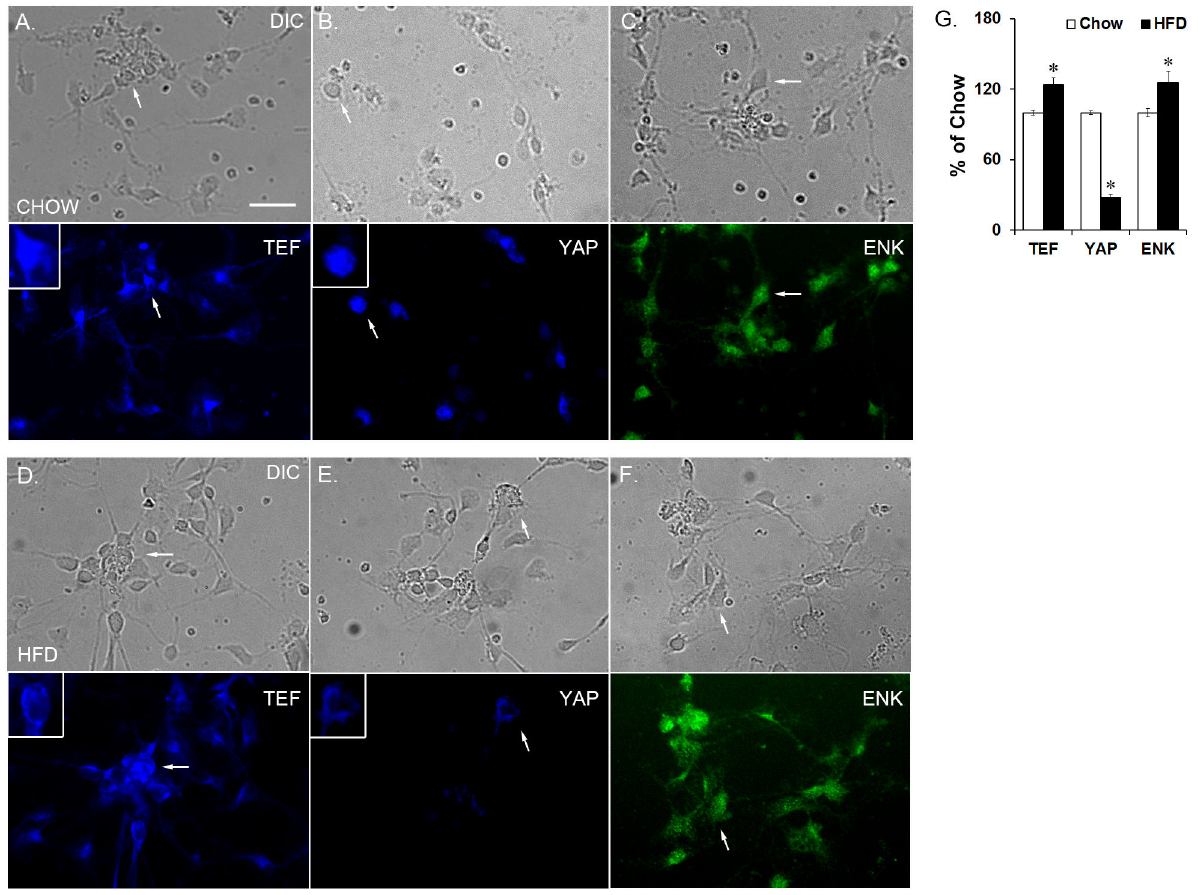
Figure 4. Isolated hypothalamic neurons from E19 embryos. Single-labeling immunocharacterization of dissociated hypothalamic neurons from chow embryos expressing (A) TEF, (B) YAP, or (C) ENK; and from HFD embryos expressing (D) TEF, (E) YAP, or (F) ENK. (G). In the HFD compared to chow embryos, there was a statistically significant decrease in the number of YAP-labeled neurons and an increase in the number of TEF- and ENK-labeled neurons. Top set of images is neurons from chow embryos, bottom set is neurons from HFD embryos. Arrows point to the same cell in the top and bottom image (DIC and fluorescence). Insert shows larger image of neuron with either cytoplasmic or nuclear localization of TEF or YAP. Results are expressed as means ± SEM (n = 4). * p < 0.05, compared with chow. ENK = enkephalin; scale bar is 25 µM.